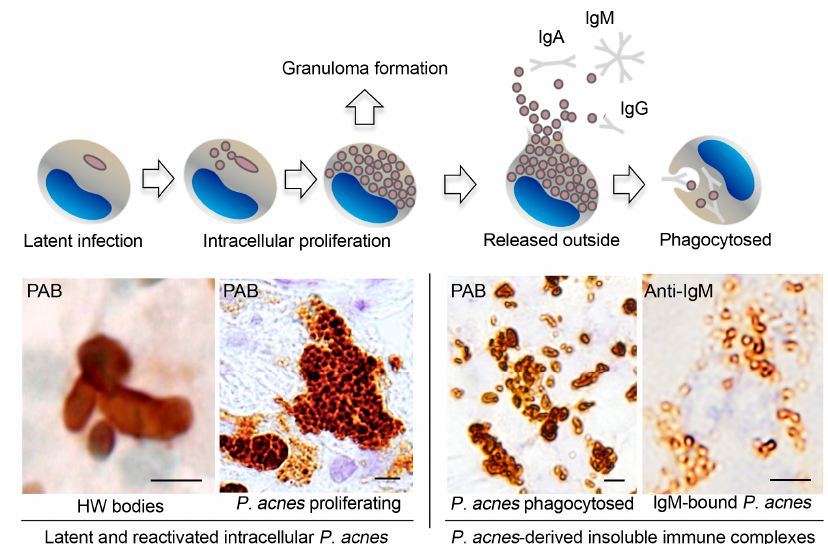
Figure 5. Intracellular proliferation of latent P. acnes followed by insoluble immune complex formation in sarcoid lymph nodes. Representative immunohistochemical features revealed by PAB or anti-IgM antibodies are shown below the illustrated macrophages with each stage of intracellular P. acnes manifestation. These findings imply that intracellular proliferation of latent P. acnes in paracortical macrophages triggers granuloma formation in sarcoidosis patients. PAB-reactive small round bodies bound with immunoglobulins (mainly IgM and IgA) are formed extracellularly and phagocytosed by sinus macrophages after release from paracortical macrophages with proliferating P. acnes that are free of immunoglobulins. Some of the P. acnes -derived immune complexes may escape local phagocytosis. All photos are original. Scale bar: 5 μ m. HW, Hamazaki–Wesenberg.